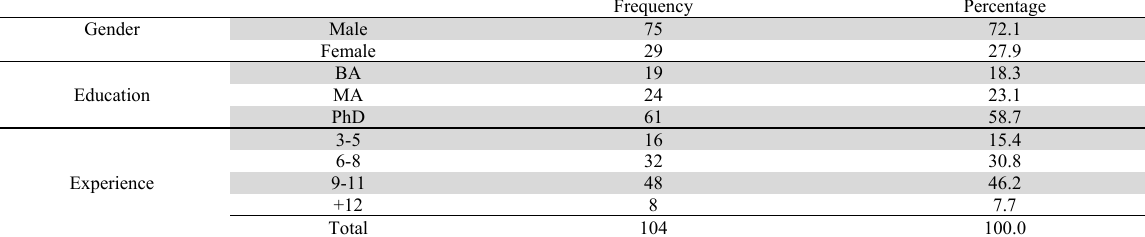
Personal characteristics of the